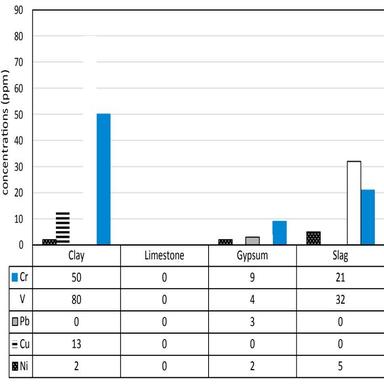
ICP plasma spectroscopy data concentrations of heavy metals in different samples.